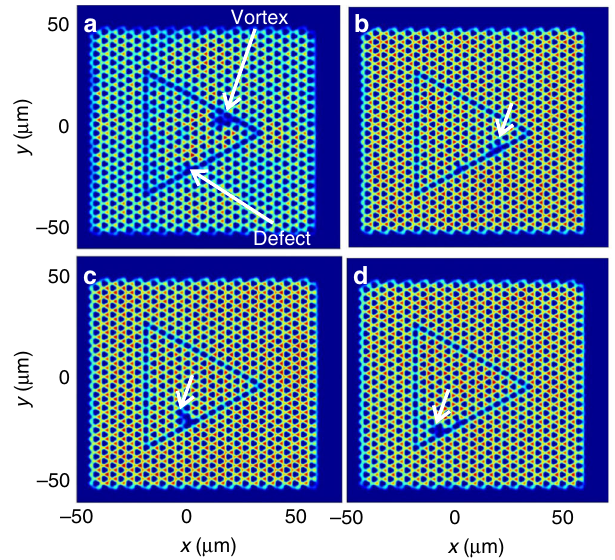
Fig. 3 Robust chiral motion of a quantum vortex on the interface. Snapshots of the vortex propagation along the interface, showing the spatial density distribution | ψ ( x , y )| 2 . Panels ( a – d ) correspond to instants t = 0, 210, 390, 480